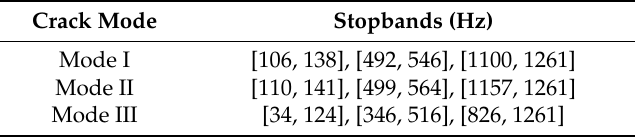
Table 2. Numerical stopbands derived from different crack modes.